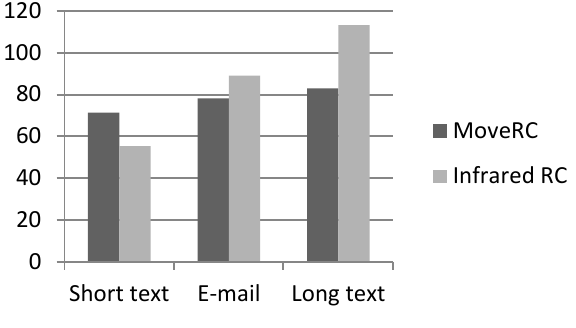
Fig. 9 – Execution time in